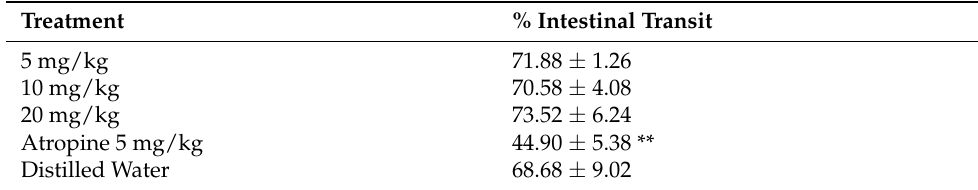
Table 2. Effect of neodulin (Compound 2 ) on gastrointestinal transit of activated charcoal meal in